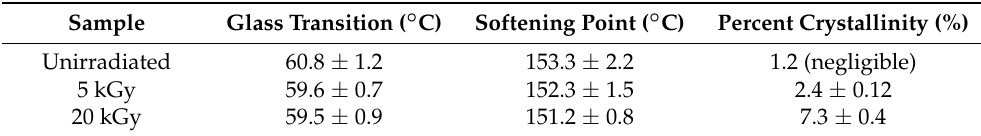
Figure 6. FTIR spectra from samples irradiated at 0, 5, 10, 15, and 20 kGy in the absence of oxygen, followed by exposure to air after irradiation. ( a ) Comparison of spectra within the range of the C=O peak; ( b ) comparison of spectra within the range of the C-O peak; ( c ) full spectra. Table 2. Average values of key thermal properties and crystallinity changes as a function of irradiation dose, calculated using DSC spectra obtained from the second heating